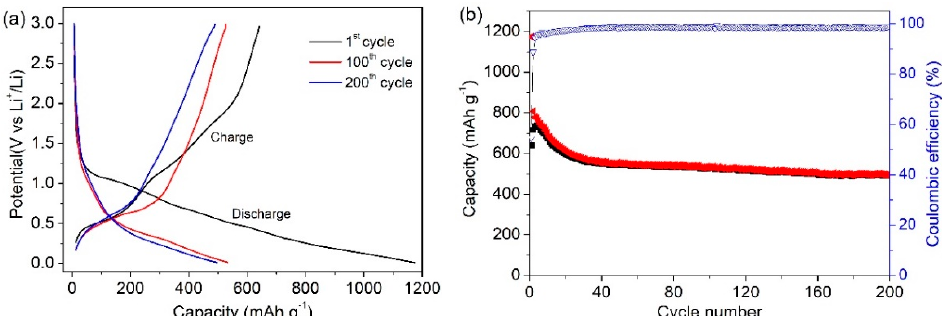
Figure 5. ( a ) Galvanostatic charge-discharge curves of the SnO 2 anode cycling at 1C. ( b ) Capacity and Coulombic efficiency versus cycle number.